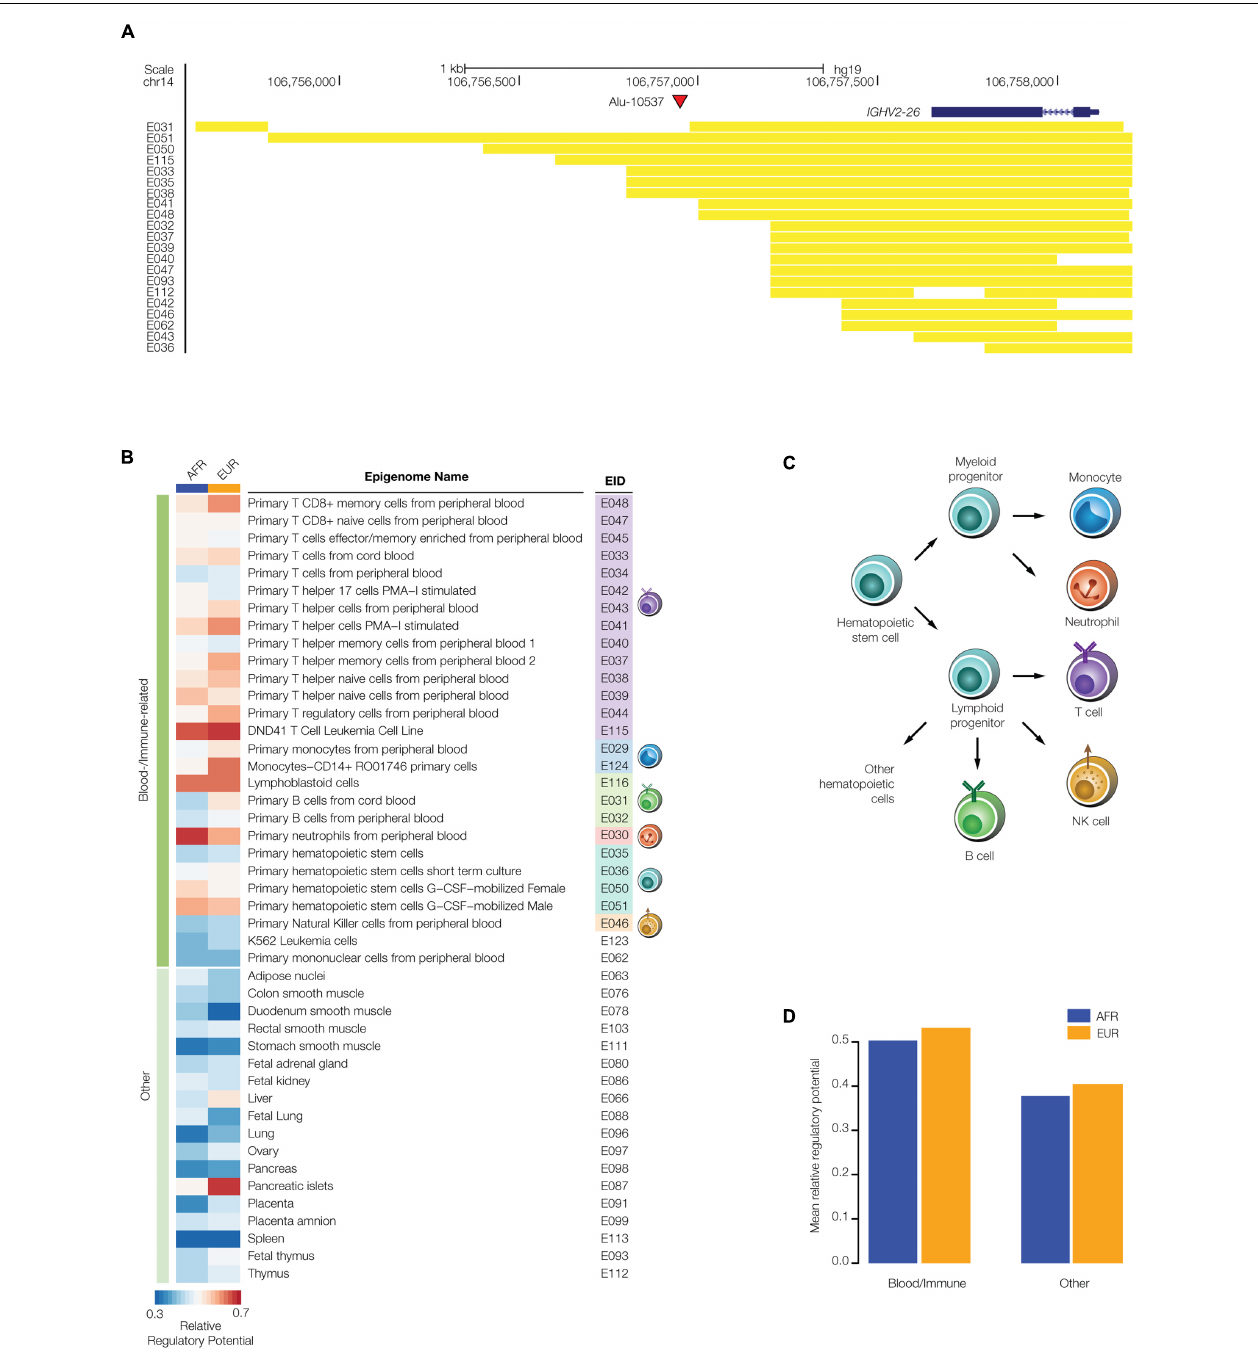
FIGURE 4 | Regulatory potential of disease-linked polyTE insertions. PolyTE insertions linked to disease-associated SNPs were evaluated for their co-location with tissue-specific enhancers. (A) UCSC Genome Browser screen capture showing an example of a polyTE insertion – Alu-10537 – that overlaps with a number of tissue specific enhancers. The genomic location of the Alu insertion on chromosome 14, downstream of the IGHV2-26 gene (blue gene model), is indicated with a red arrow. The genomic locations of co-located enhancers, characterized based on chromatin signatures from a variety of tissue-specific epigenomes, are indicated with yellow bars. (B) Heatmap showing the relative regulatory potential (see Materials and Methods section Evaluating polyTE Regulatory Potential) of polyTE insertions for a variety of tissue-specific epigenomes. Blood- and immune-related tissues are shown separately from examples of the other tissue types analyzed here. (C) Developmental lineage of immune-related cells for which enhancer genomic locations were characterized. (D) The mean relative regulatory potential for disease-linked polyTE insertions is shown for blood- and immune-related tissues compared to all other tissue-types analyzed here. Values for the African (AFR – blue) and European (EUR – orange) population groups are shown